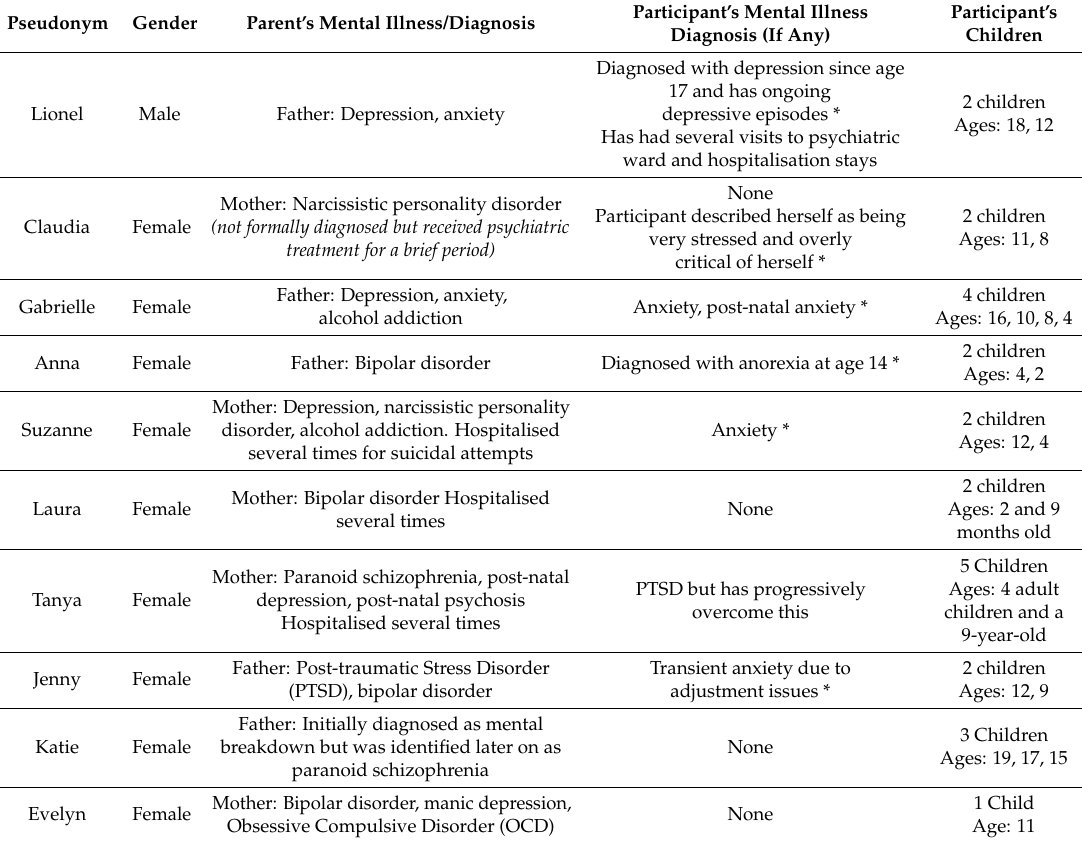
Table 1. Participant family